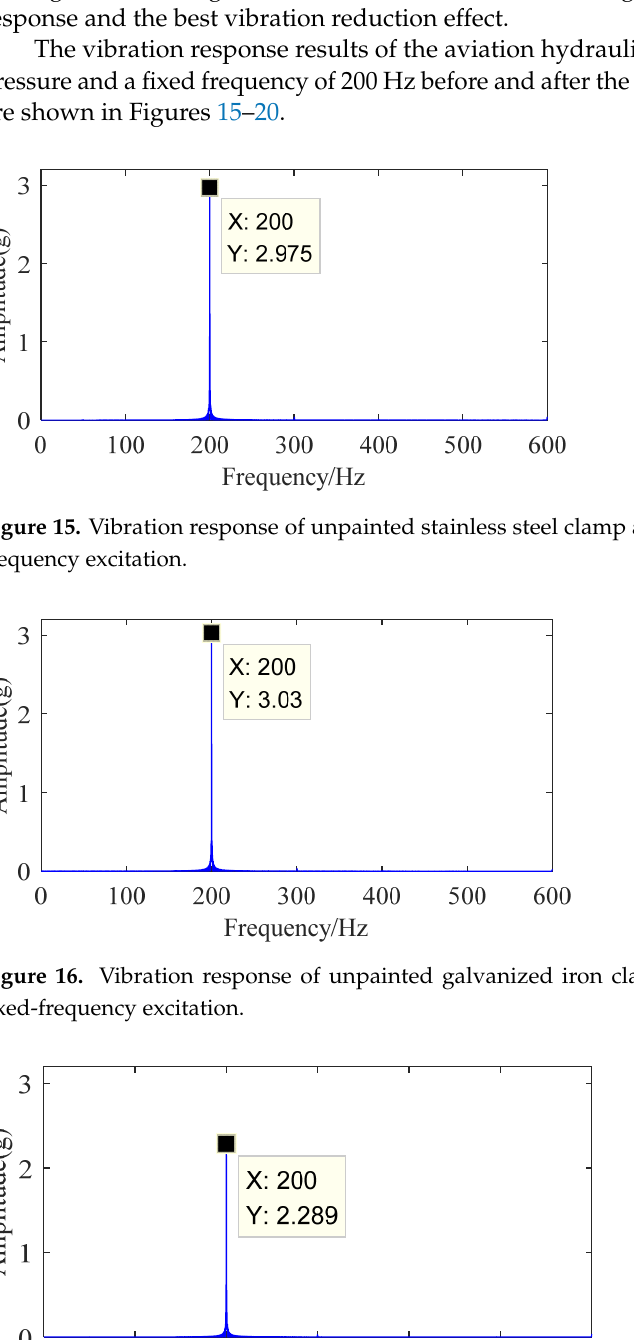
Figure 18. Vibration response of galvanized iron clamp with a 200- μ m-thick hard coating of Al-Cu- Fe-Cr under 200 Hz fixed-frequency excitation. Figure 19. Vibration response of 304 stainless steel clamp with 200- μ m-thick hard coating of Z r O 2 - PTFE under 200 Hz fixed-frequency excitation.